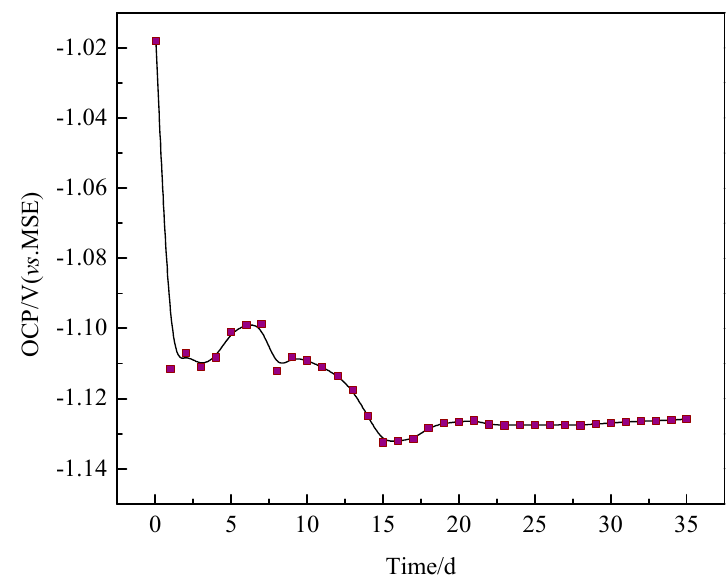
Figure 4. The trend of open circuit potential (OCP) for Q235B steel in desulfurization solution.